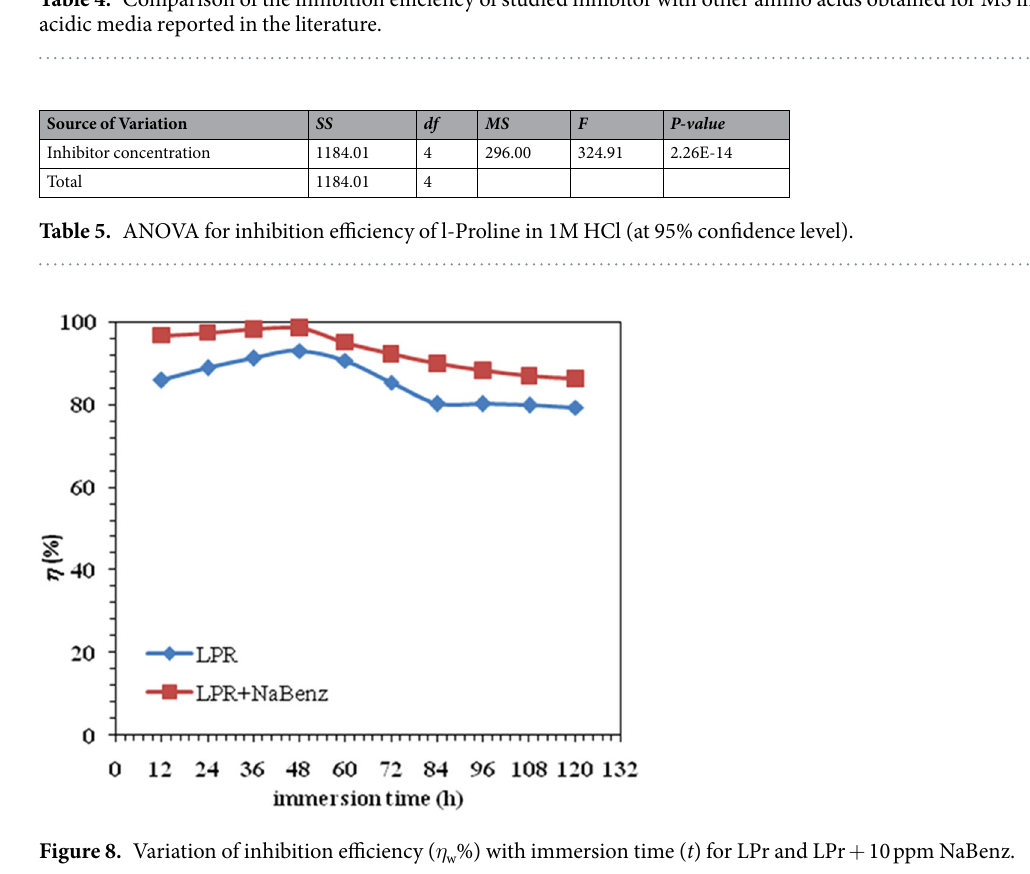
Figure 8. Variation of inhibition efficiency ( η w %) with immersion time ( t ) for LPr and LPr + 10 ppm